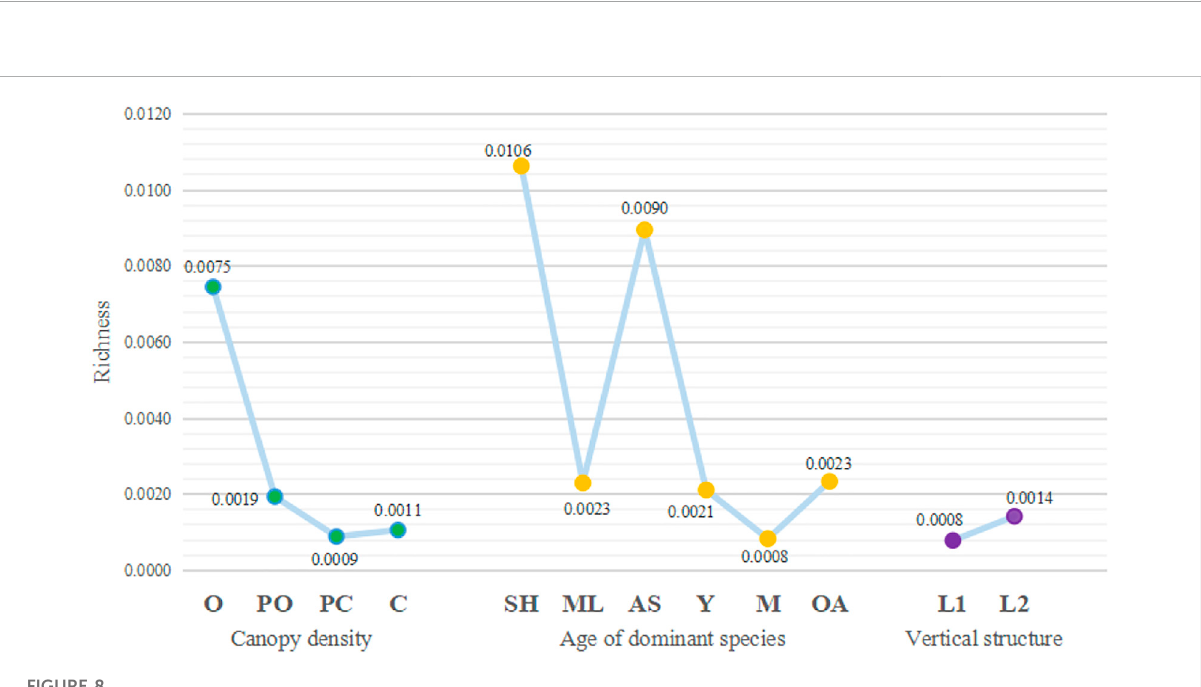
FIGURE 8 Spontaneous vegetation richness in single vegetation